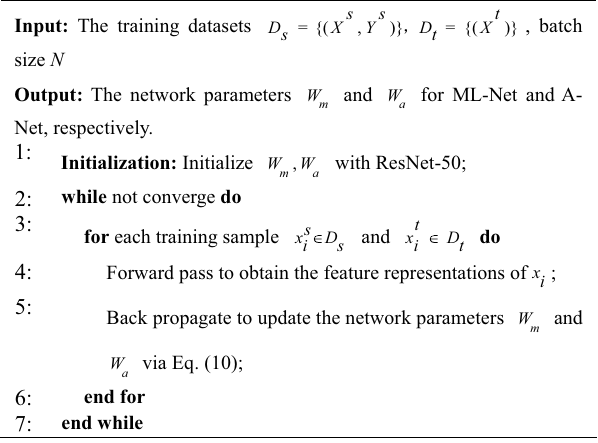
Algorithm 1 The training process of